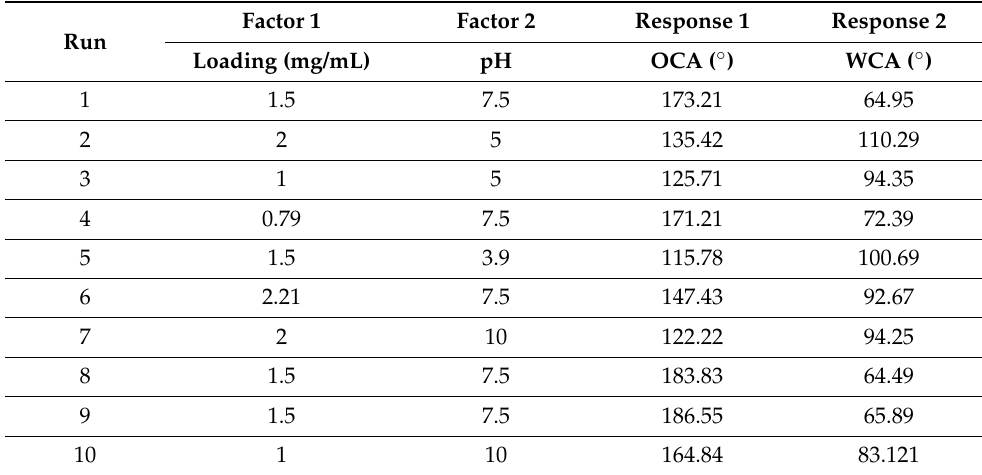
Table 2. CCD design matrix of 2 2 factorial and experimental